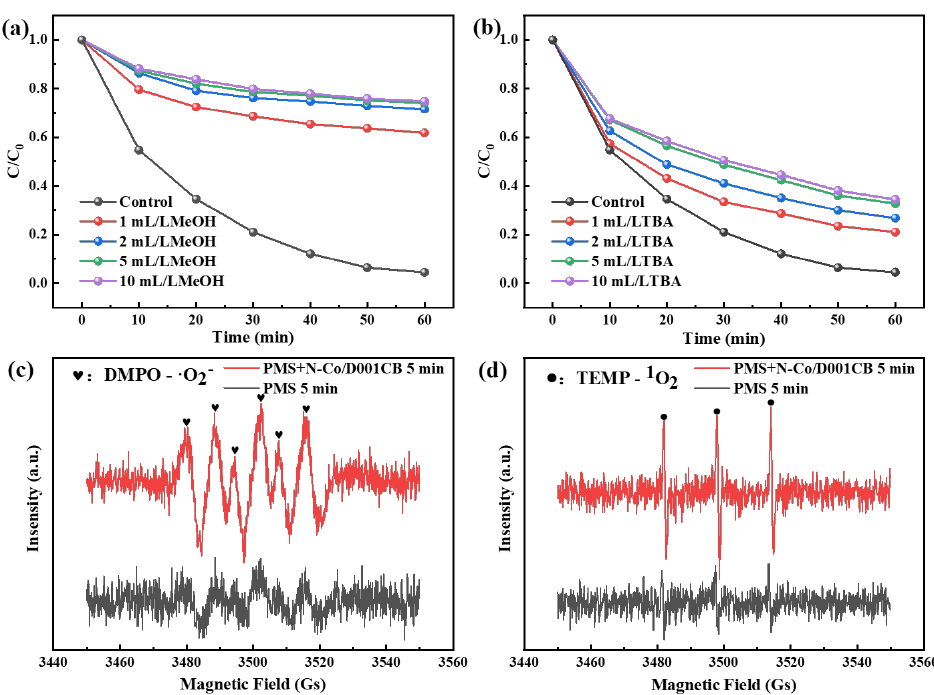
Figure 8. The influence of MeOH ( a ); and TBA ( b ) on the catalytic degradation of ibuprofen. EPR test with DMPO or TEMP to detect ·O 2 − ( c ); and 1 O 2 ( d ) in the reaction system (temperature = 25 °C, pH = 4.5, PMS concentration = 0.7 mM, catalyst added = 0.3 g/L, IBU concentration = 10 mg/L).